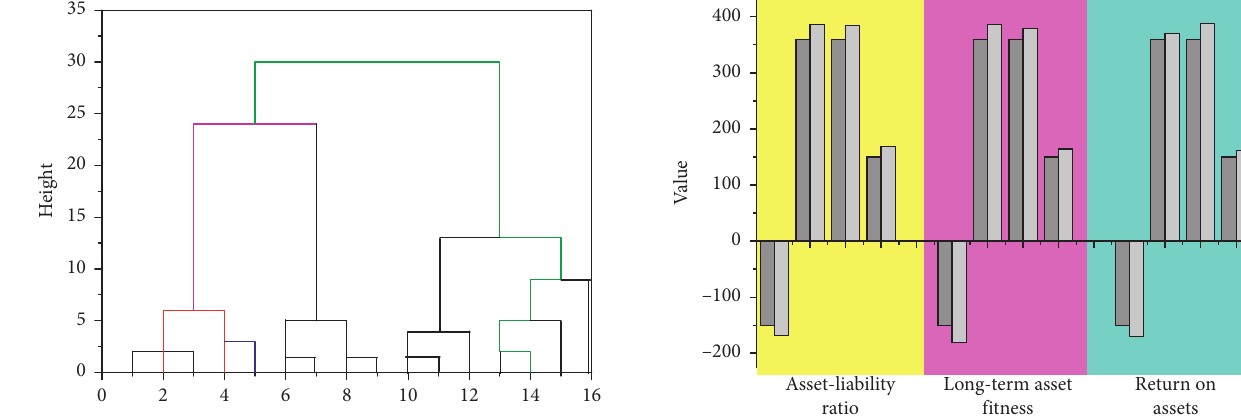
Figure 8: Cluster analysis of hidden node activation values.